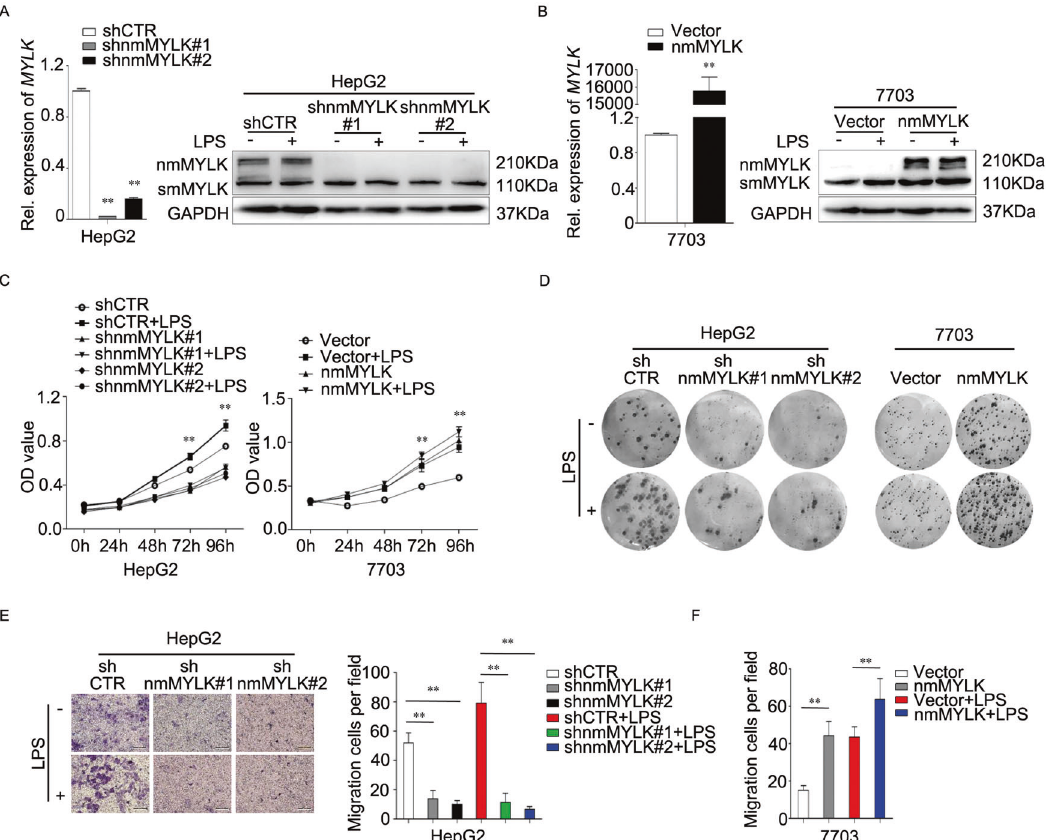
Fig. 2 nmMYLK promote the proliferation of HCC cells. A – F HepG2 cells were transfected with shRNA-nmMYLK lentivirus or lentivirus-vector control before LPS treatment, 7703 cells were transfected with nmMYLK expression constructs or its vector before LPS treatment. The expressions of MYLK in HepG2 and 7703 cells were detected using qRT-PCR and western blot ( A, B ). Cell proliferation abilities were examined using MTS assay ( C ) and Colony formation assay ( D ). Cell migration abilities were examined using Transwell test ( E, F ). The experiments were repeated three times independently, and the bars represent SD. ** P <